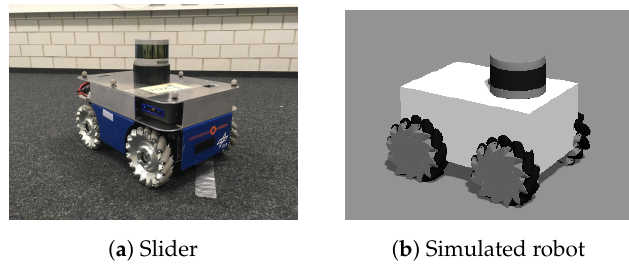
Figure 2. Robotic platform equipped with Velodyne VLP-16 and an on-board